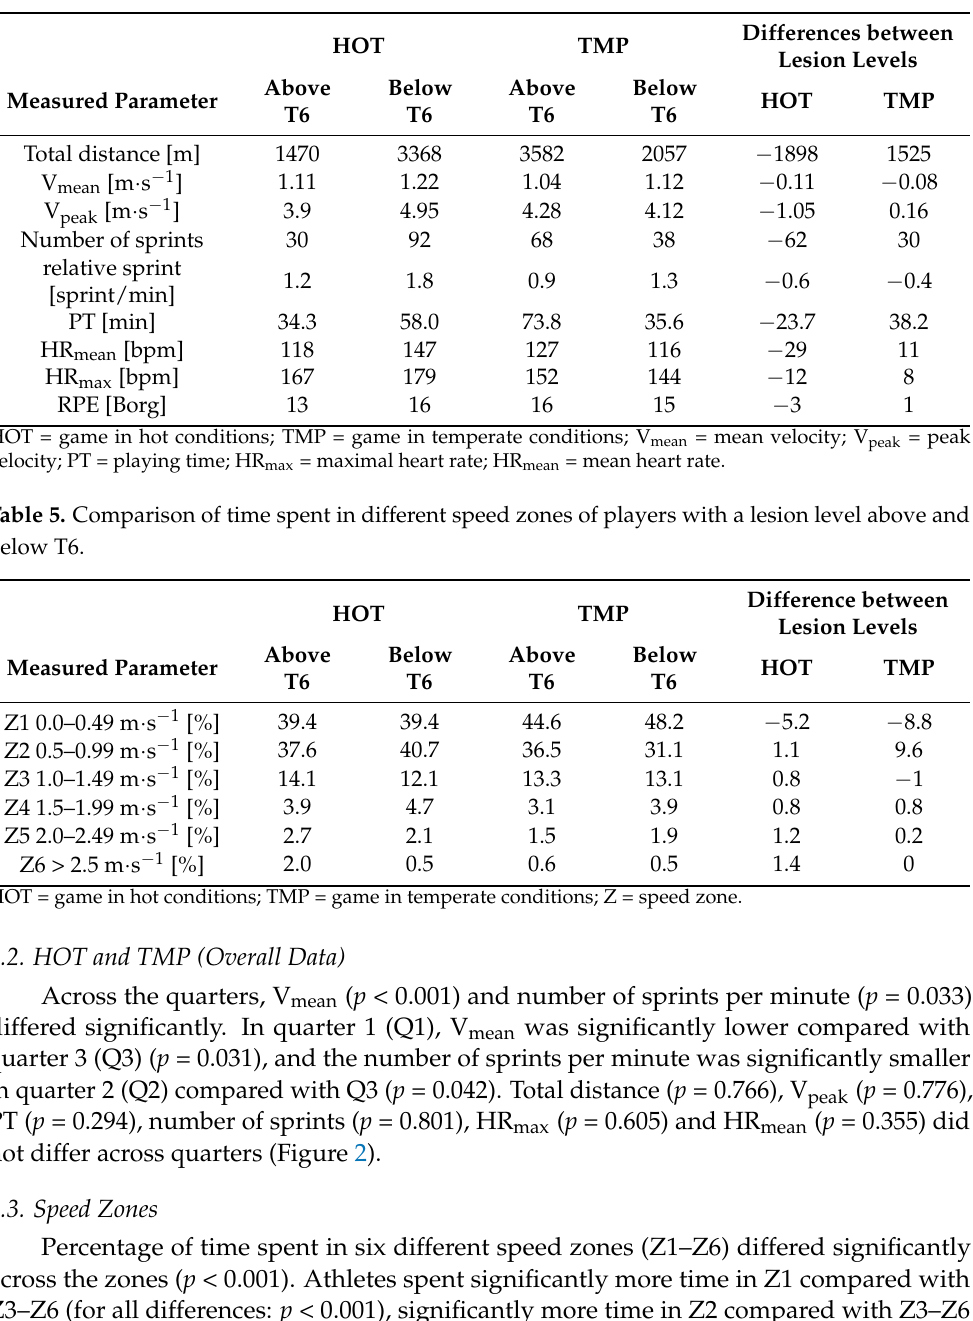
Table 4. Comparison of players with a lesion level above and below T6. Measured Parameter Total distance [m] 1470